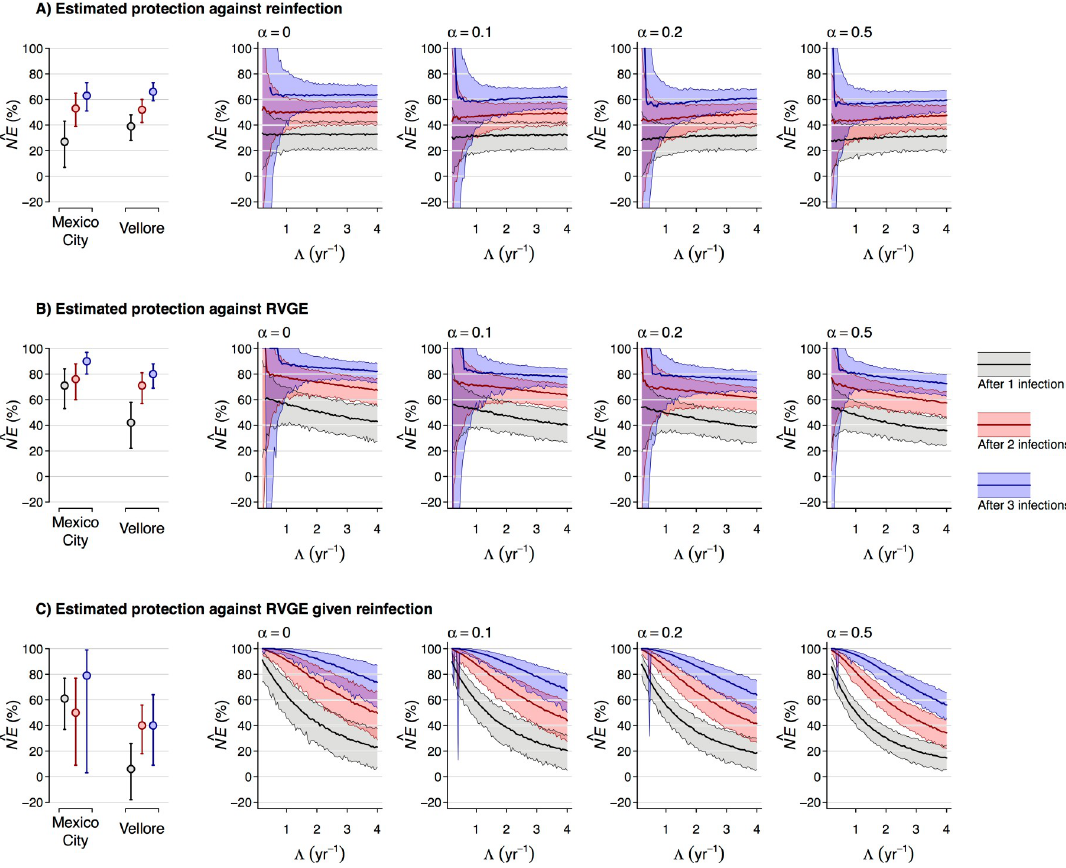
Fig 3. Sources of bias in estimates of naturally-acquired immune protection. We compare “na ï ve” estimates of naturally-acquired immunity ( ^ NE ) against re-infection ( A ), against RVGE incidence ( B ), and against RVGE given re-infection ( C ) following one (grey), two (red), or three (blue) previous infections in simulated cohorts. We parameterize the natural history model with estimates of natural protection against re-infection ( ψ ), age-specific risk of RVGE given infection ( β ), and excess infection and RVGE risk within the “high- risk” subgroup ( ϕ , ρ ) from Model 1 ( Table 1 , Fig 2 ). We vary the force of infection ( Λ , measured as infections per susceptible person- year-at-risk) and the proportion of children assumed to belong to the “high-risk” subgroup ( α ). Consistent with primary analyses of the cohort data, simulated (“na ï ve”) analyses do not account for age-dependent RVGE risk. The plotted values can be interpreted as predictions of estimated natural immunity against rotavirus infection, RVGE, and RVGE given infection, across sites with differing force of infection (x-axes) or prevalence of high-risk individuals (panels left to right). We plot estimates from the original cohort datasets within the left panels of each row (circles, with 95% confidence intervals), revealing that the higher force of infection and prevalence of “high-risk” individuals in Vellore can explain some, although not all, of the difference in estimates of immune protection between the Vellore and Mexico City